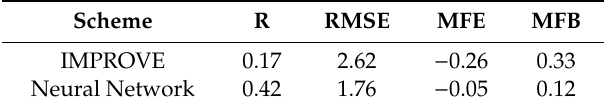
Figure 10. Time series of daily mean visibility obtained from observation and WRF-Chem model simulation corrected by the neural network in Jiangsu Province in winters of 2014–2017. Table 3. R, RMSE, MFE and MFB of daily mean visibility (360 days by length) between observation and WRF-Chem model simulation corrected by neural network in Jiangsu Province in winters of 2014–2017.